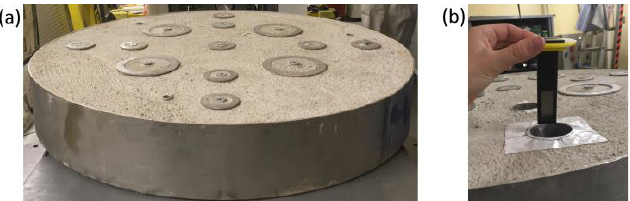
Fig. 2. (a) Overview of the concrete matrix slice of 1 m diameter (b) Uranium sample in its holder inserted in the matrix